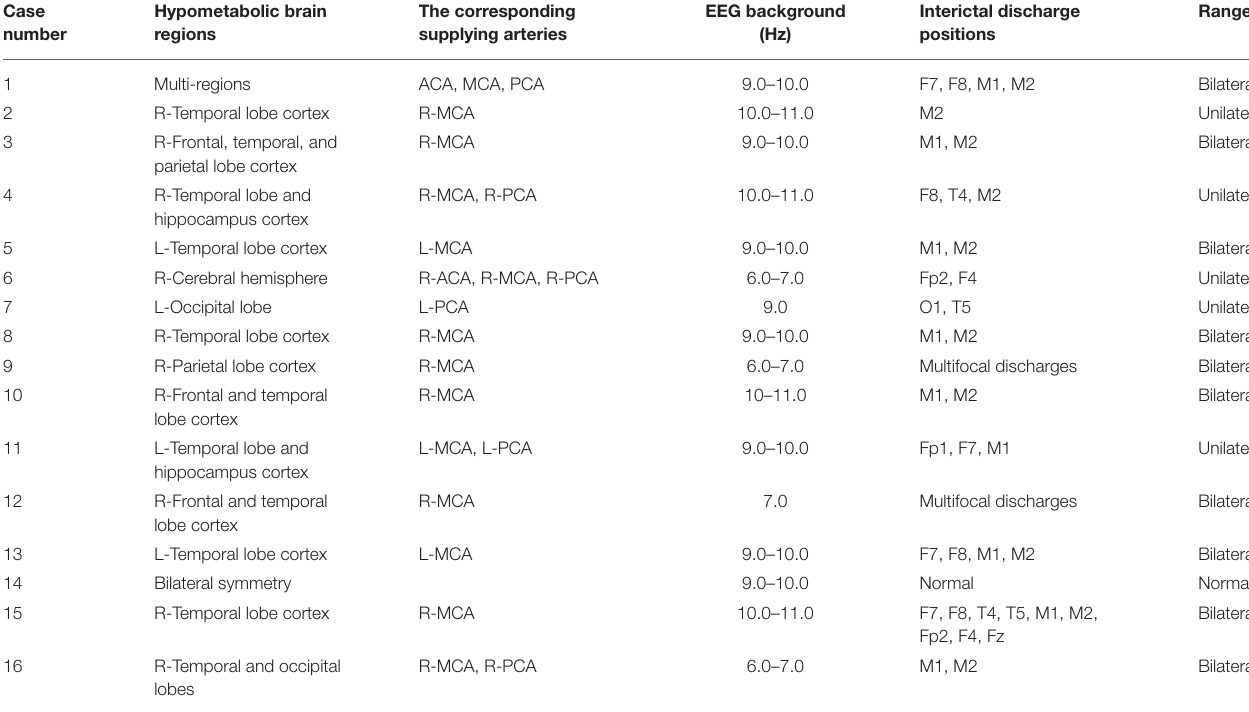
TABLE 2 | The FDG 18 -PET-CT and interictal discharge manifestations of the cases. Case